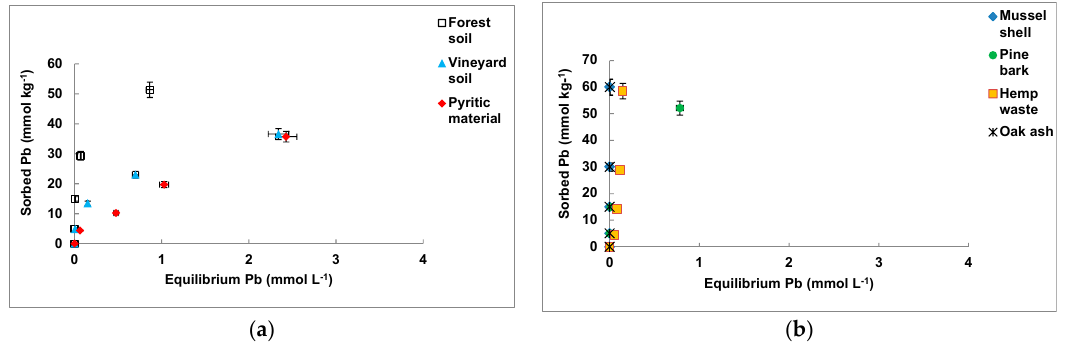
Figure 2. Pb sorption curves for the forest soil, vineyard soil, and pyritic material ( a ), and for the by-products studied ( b ). Average values (with error bars) for three replicates, with coefficients of variation always <5%.